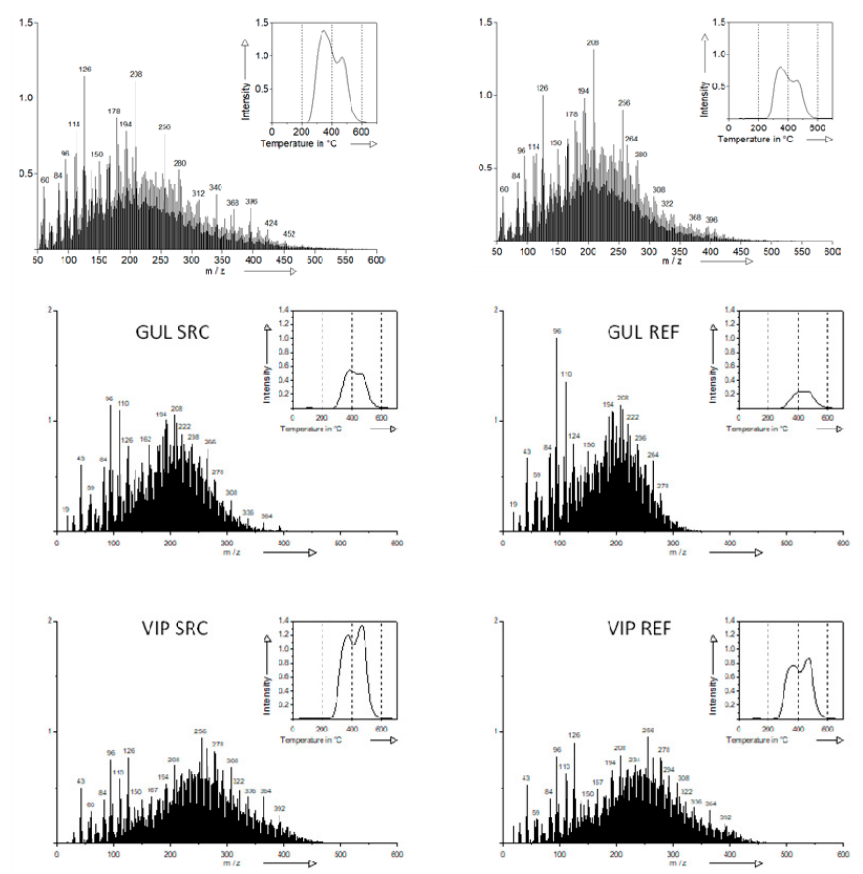
Figure 3. Py-FI mass spectra and thermograms (inserts) of the upper topsoil (0–5 cm soil depth) under a 15-year old short rotation coppice (SRC) at the test site Gülzow and a former SRC with hybrid poplar clones 4 years after return to tilled annual crops and with continuously tilled annual crops at the test site Vipperow and adjacent reference sites with cereals or grasses (REF) at both sites.